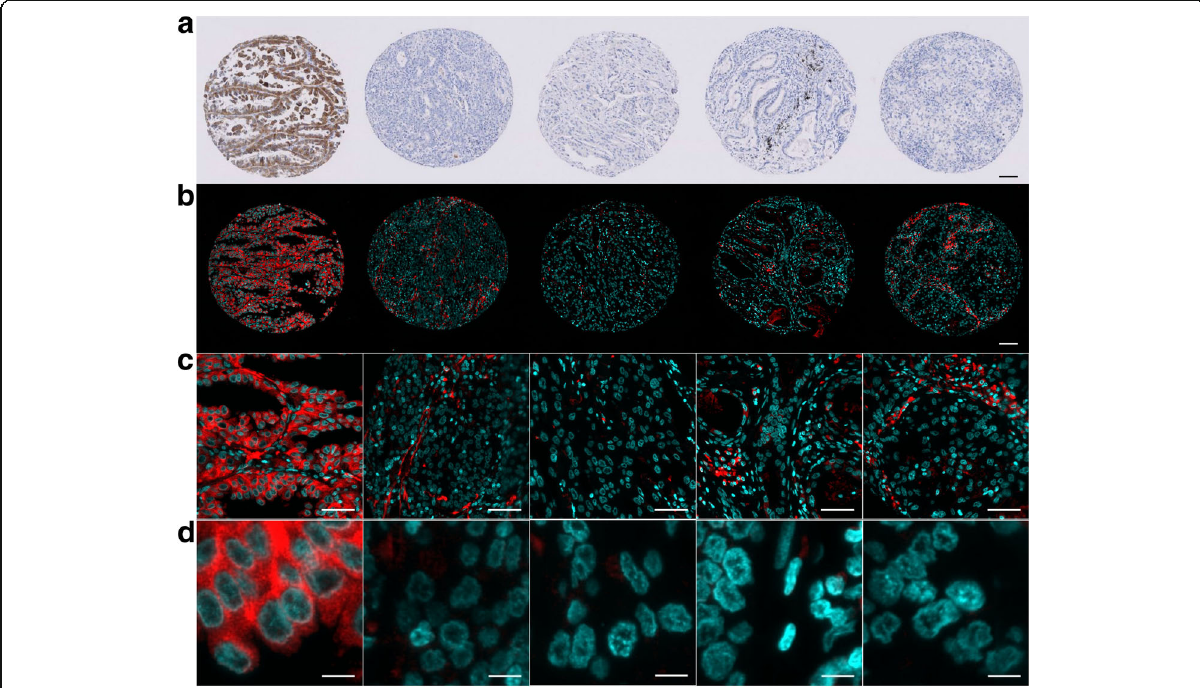
Fig. 4 ALK MTP-IF on five lung ADC from a NSCLC TMA. a Shown are five tumor cores including one ALK-positive case next to four ALK-negative cases (left to right) as assessed by chromogenic IHC; the black coloration visible on the fourth core is anthracosis. The same cores as in ( a ) have been stained for ALK by MTP-based IF ( b - d ) employing the same protocol as for the ALK-positive ADC cases in Fig. 3. Scale bar 100 μ m ( a - b ), 50 μ m ( c ) and 10 μ m ( d )